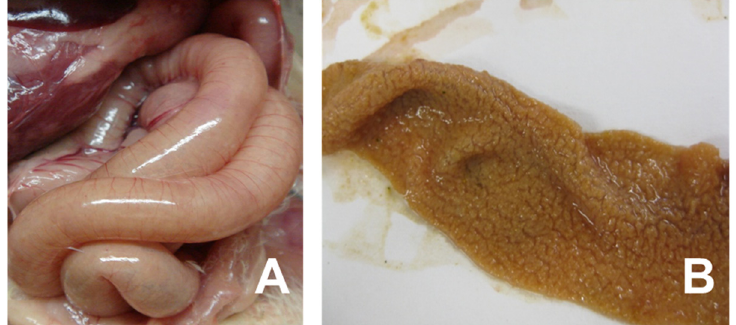
Figure 1. Clinical signs of necrotic enteritis in chickens. Panel ( A ) indicates small intestine showing friable, dilated and thin-walled filled with gas. Panel ( B ) shows jejunal/ileal mucosal exhibiting typical yellow pseudo-membrane, often called as Turkish towel appearance.